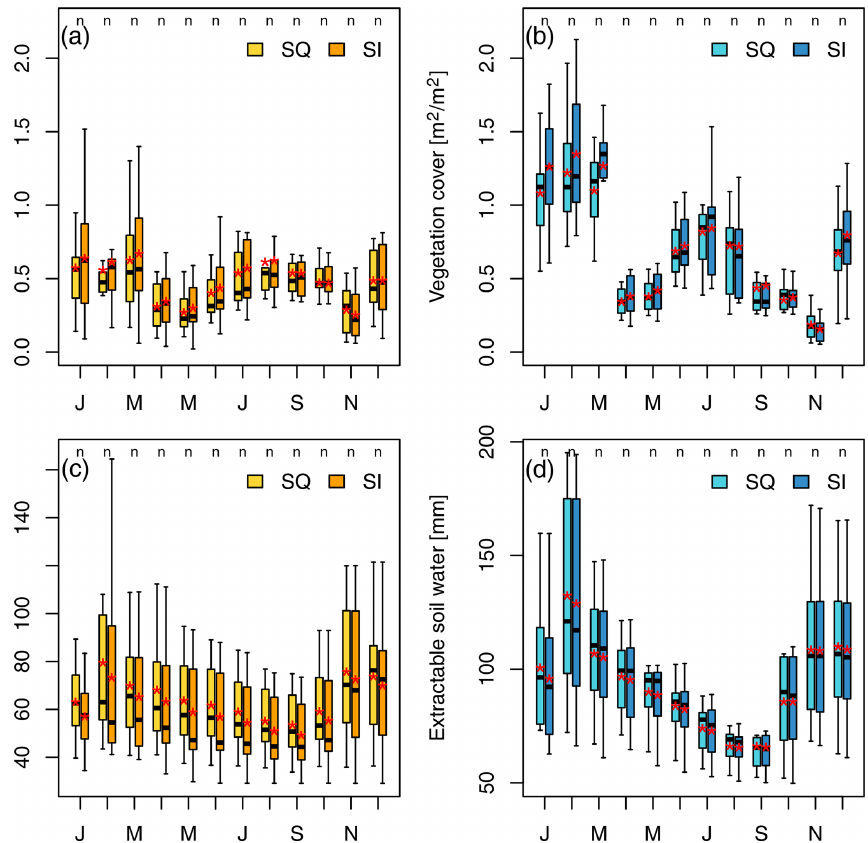
Figure 6. Monthly cropland leaf area index (LAI) at Selwana (a) and Gabaza (b) as well as monthly extractable soil water at Selwana (c) and Gabaza (d) . The abbreviations used in the figure are as follows: SQ – status quo management, SI – minimum sustainable intensification, and n – non-significant difference between SQ and SI. Red asterisks represent mean